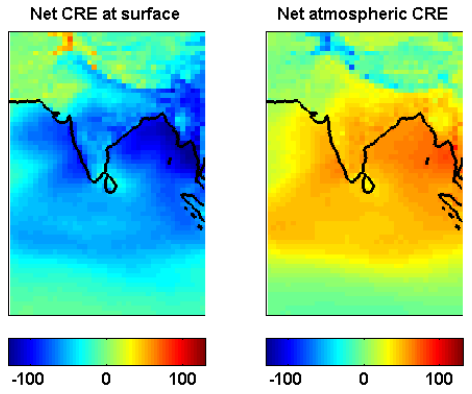
Figure 7. The net cloud radiative effect (in Wm − 2 ) at surface and in the atmosphere based on CERES data averaged over the summer monsoon months